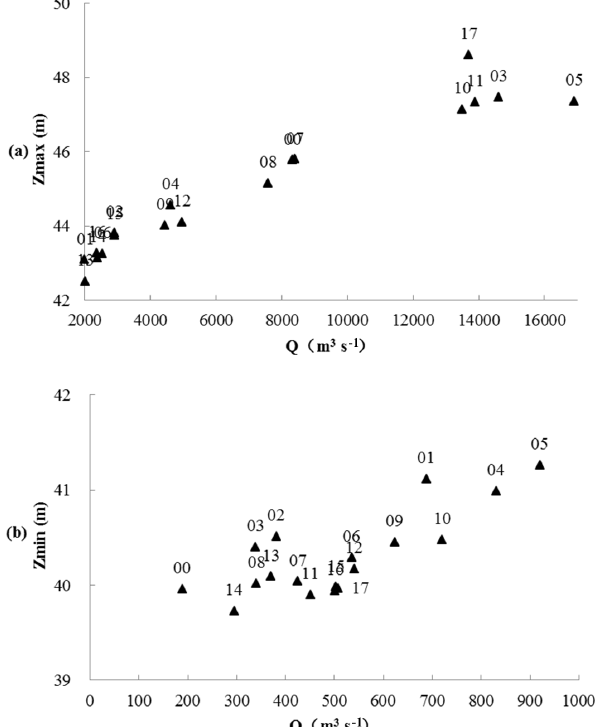
Figure 2. Relationship between annual average daily water levels and corresponding discharge at the Huangzhuang station for the pe- riod 2000–2017, (a) maximum water level, and (b) minimum water level. The numbers refer to the years, e.g. 00 means